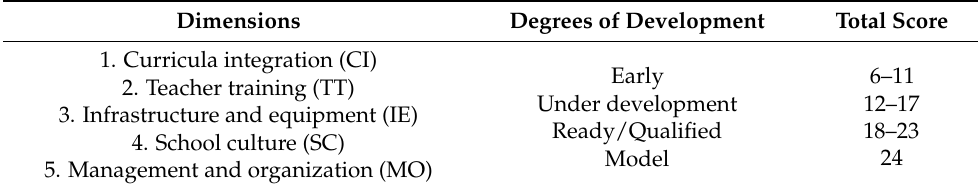
Table 2. STEM rubric: degrees of development according to total